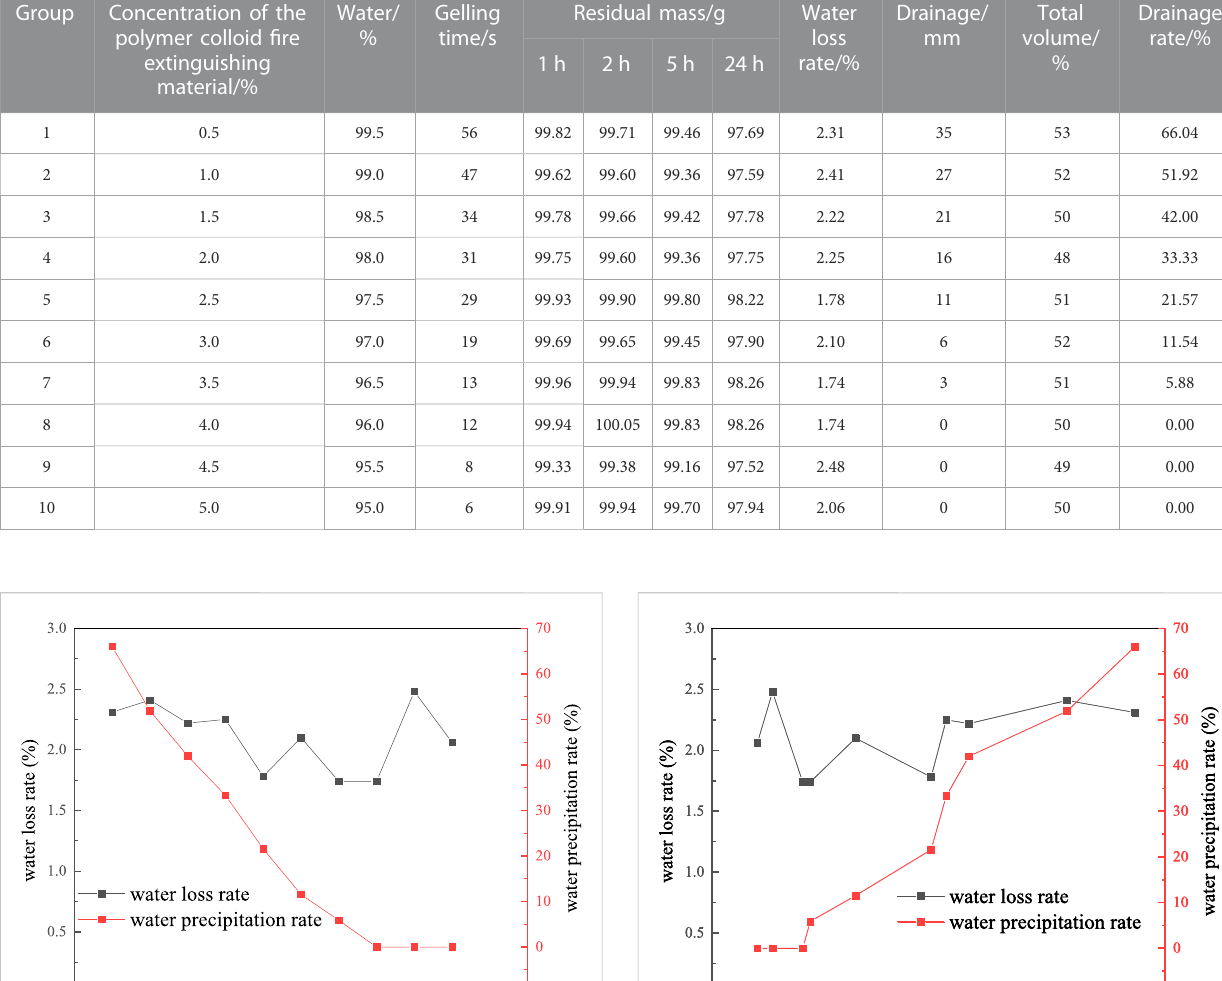
TABLE 3 Calculation results of the water loss rate and water precipitation rate of the polymer colloid fi re extinguishing agent. Group